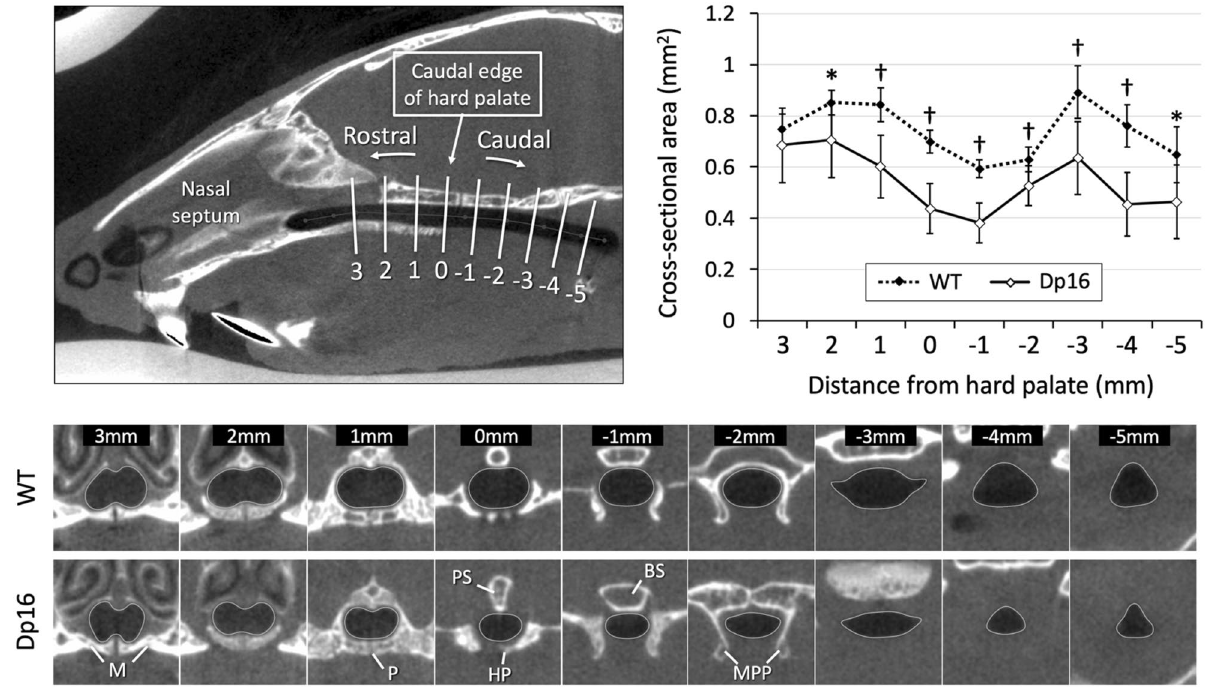
Figure 3. Evaluation of the upper airway and statistical comparison of its cross-sectional areas. (Upper left) The caudal edge of the hard palate was used as a landmark (0). Nine consecutive cross-sectional images perpendicular to the upper airway were obtained at 1 mm intervals. (Bottom) The representative images from a mouse of each genotype are shown. (Upper right) Cross-sectional areas were measured and plotted at each point. Values are presented as means ± SD. * P < 0.05; † P < 0.001. M maxilla, P palatine, PS presphenoid, HP hard palate, BS basisphenoid, MPP medial pterygoid plate.